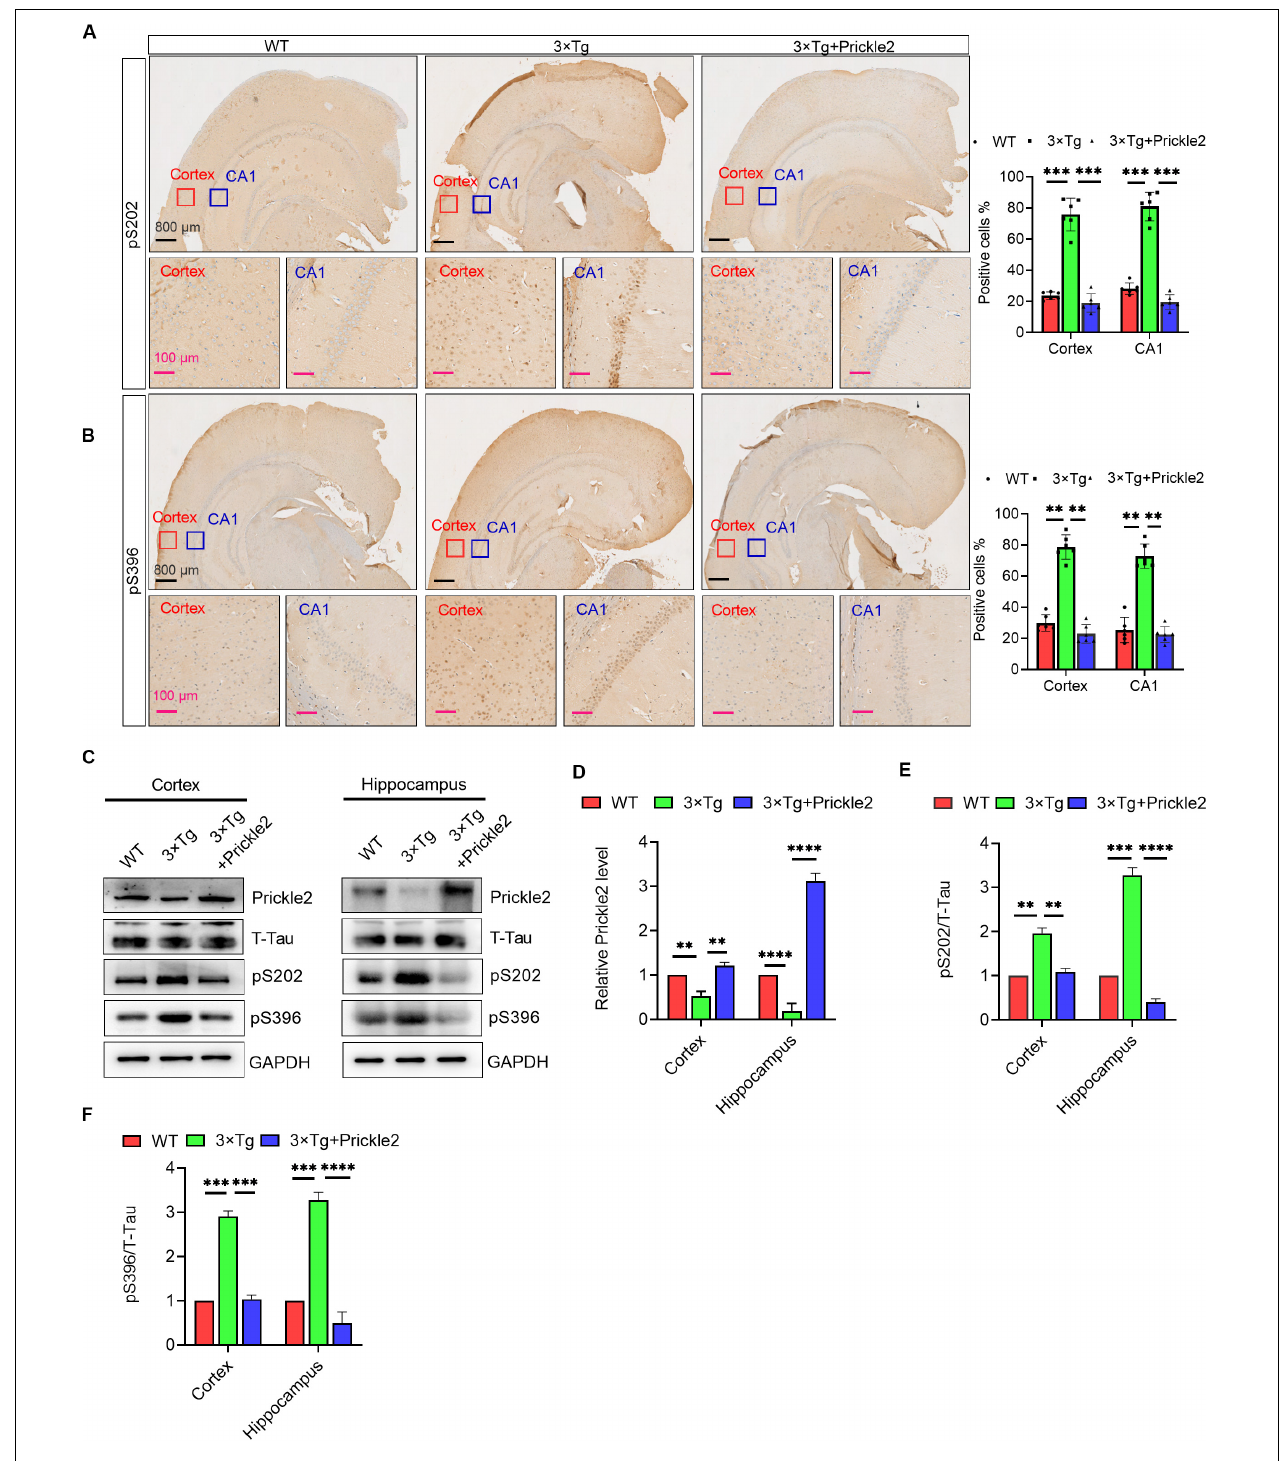
FIGURE 5 | Prickle2 treatment reduces Tau phosphorylation in 3 × Tg mice. (A) Representative IHC images of WT, 3 × Tg and 3 × Tg/Prickle2 treatment mice stained with anti-Tau (phospho S202) antibodies. The proportions of pS202-positive cells were calculated in cortical and hippocampal, respectively ( n = 6 per group). (B) Representative IHC images of WT, 3 × Tg and 3 × Tg/Prickle2 treatment mice stained with anti-Tau (phospho S396) antibodies. The proportions of pS396-positive cells were calculated in cortical and hippocampal, respectively ( n = 6 per group). (C) Western blots detected the phosphorylated Tau using pS202 and pS396 antibodies in the brain tissues from WT, 3 × Tg and 3 × Tg/Prickle2 mice. (D–F) Quantification of the protein levels of phosphorylated Tau by densitometric analyses ( n = 6 per group). (B–D) ANOVA followed by Bonferroni’s post hoc test. ∗∗ p < 0.01; ∗∗∗ p < 0.001; ∗∗∗∗ p < 0.0001.